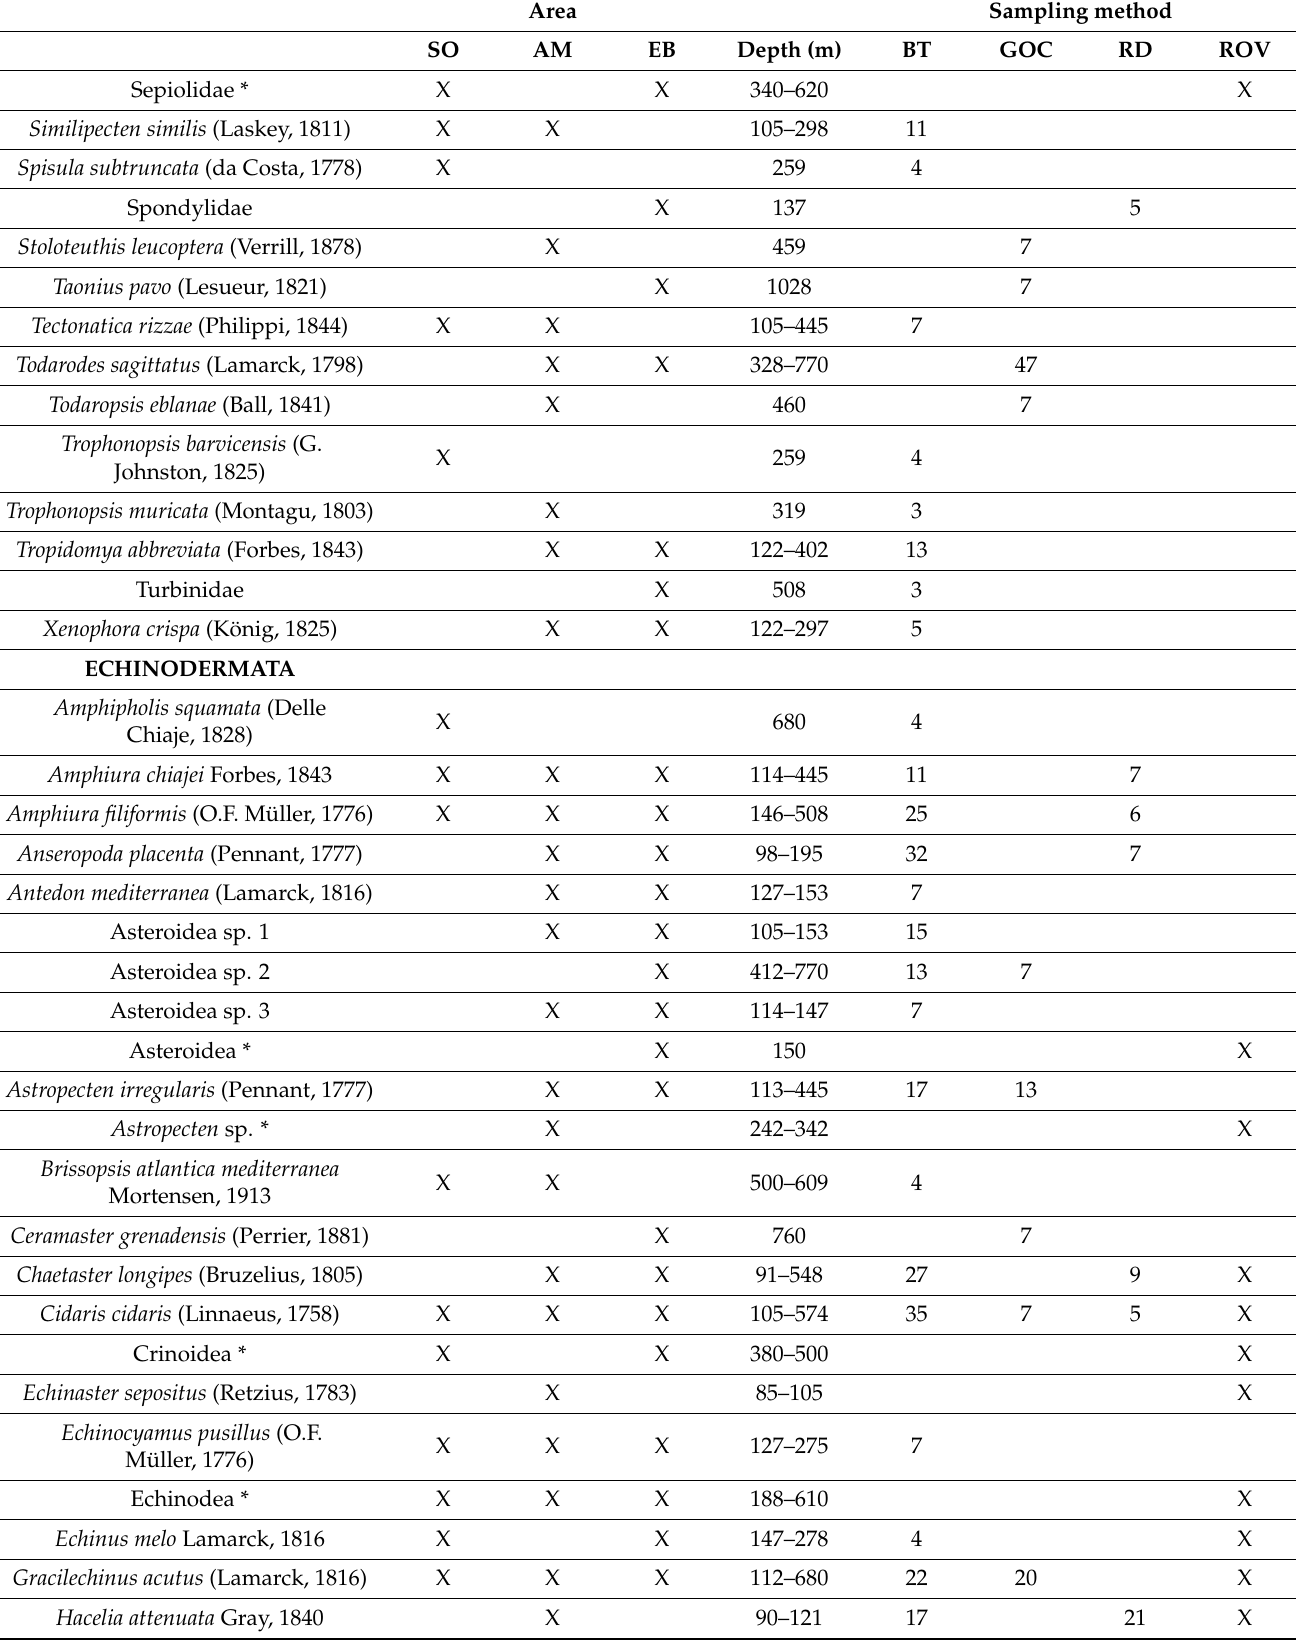
Table A7. Cont. Area Sampling